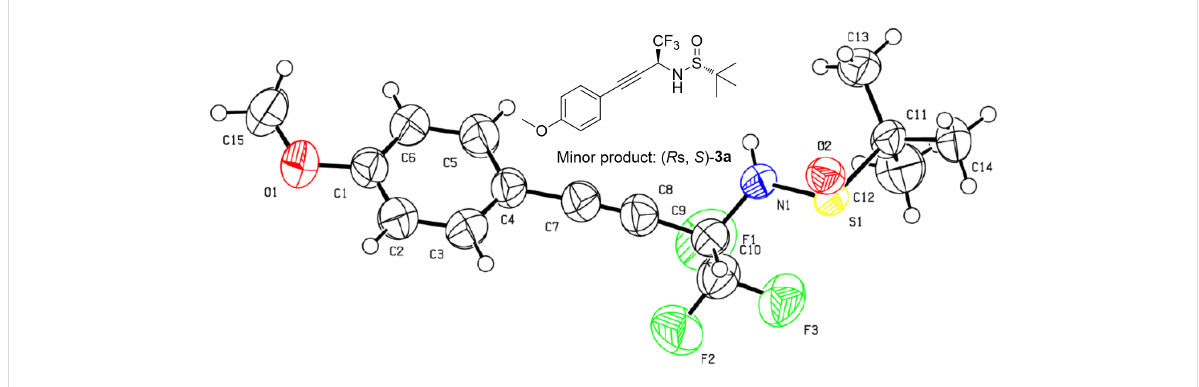
Figure 2: ORTEP diagram showing of the minor product of 3a .